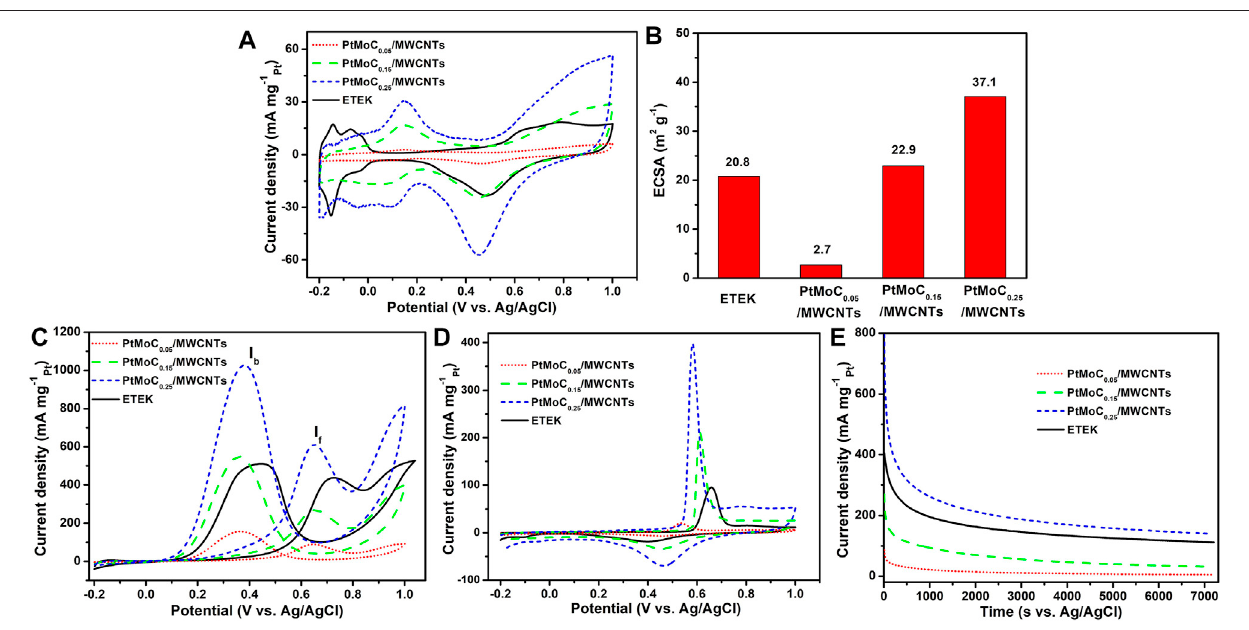
FIGURE 7 | CV of the catalysts (A) in a N 2 -saturated 0.5 M H 2 SO 4 solution, (B) ECSA, (C) in a N 2 -saturated 0.5 M H 2 SO 4 + 1 M CH 3 CH 2 OH solution, (D) CO stripping voltammograms in a 0.5 M H 2 SO 4 solution at 25 ° C with a scan rate of 50 mV s − 1 and (E) CA curves of the catalysts in a N 2 -saturated 0.5 M H 2 SO 4 + 1 M CH 3 CH 2 OH solution at 25 ° C.